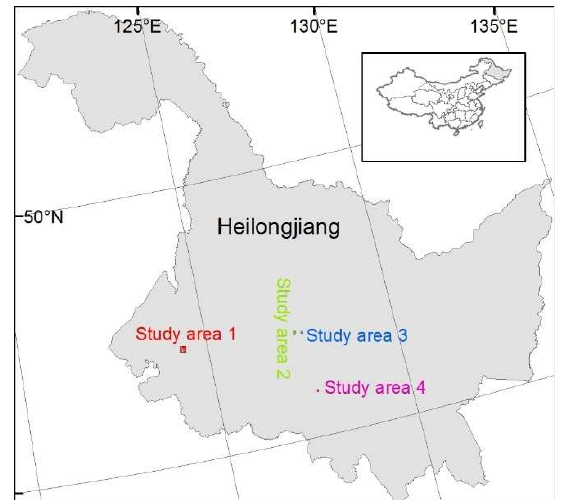
Figure 1. Four study area locations in Heilongjiang province, China.